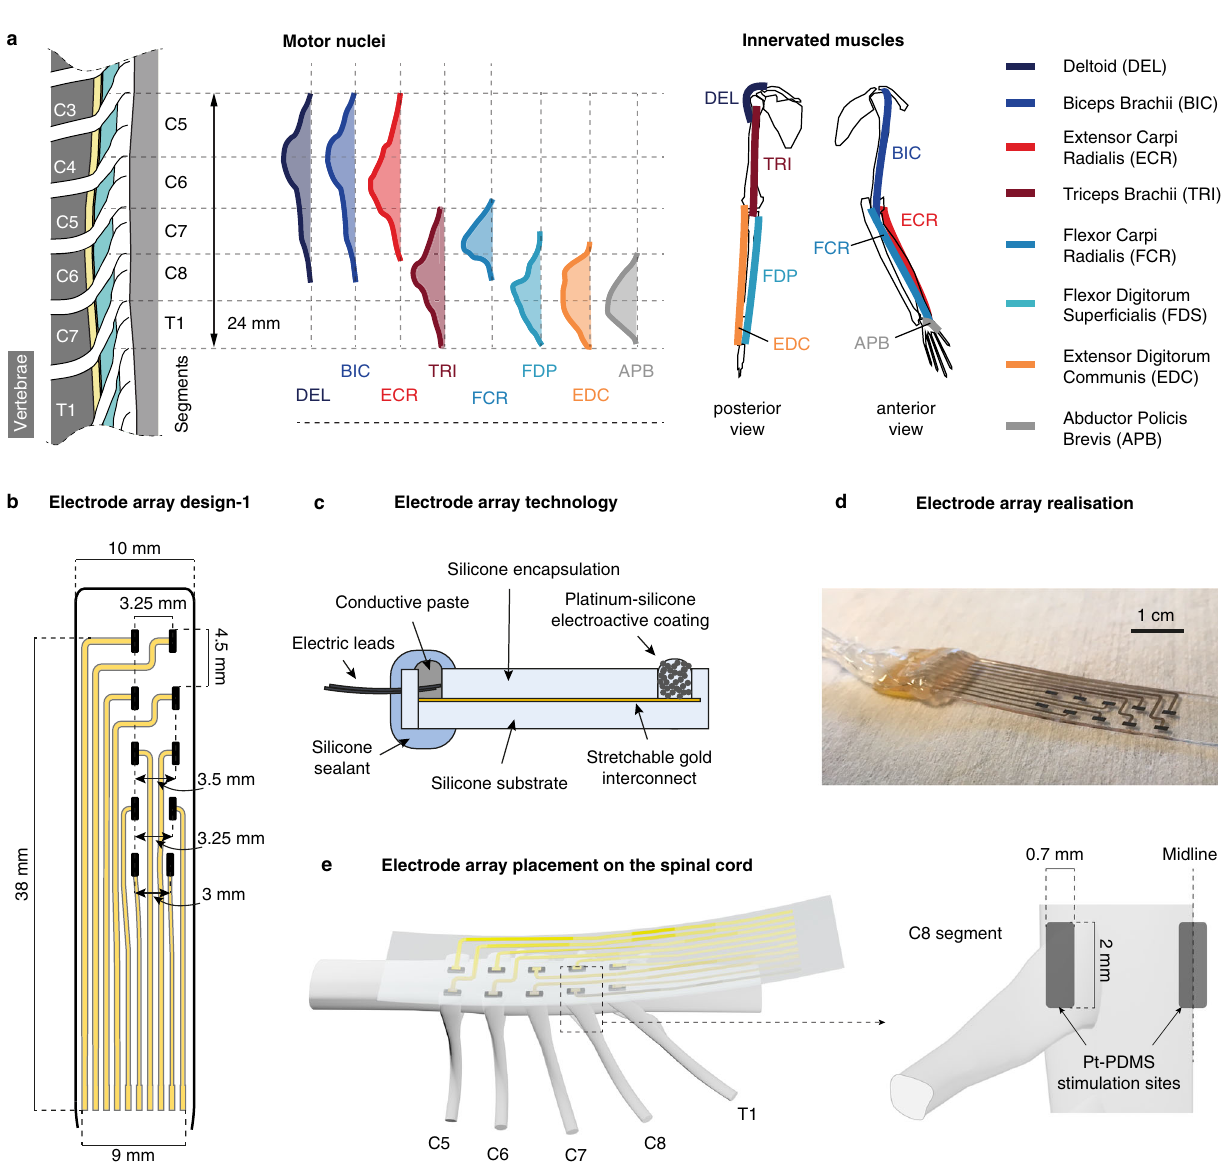
Fig. 3 Organization of the monkey cervical spinal cord and soft electrode array tailored to the epidural space of the cervical spinal cord. a Distribution of the motor nuclei of 8 upper-limb muscles in the monkey cervical spinal cord 27 and skeletal positions of these upper-limb muscles. b Layout of a custom electrode array with 5 lateral and 5 medial electrode contacts (design-1) tailored to the monkey cervical spinal cord. c Cross-section diagram of a soft electrode array. d Photograph of a fabricated soft electrode array. Scale bar: 1 cm. e Placement of the electrode array relative to the cervical spinal cord. Lateral electrode contacts were made to face individual dorsal roots while medial contacts were made to be along the midline of the dorsal columns. Pt- PDMS: